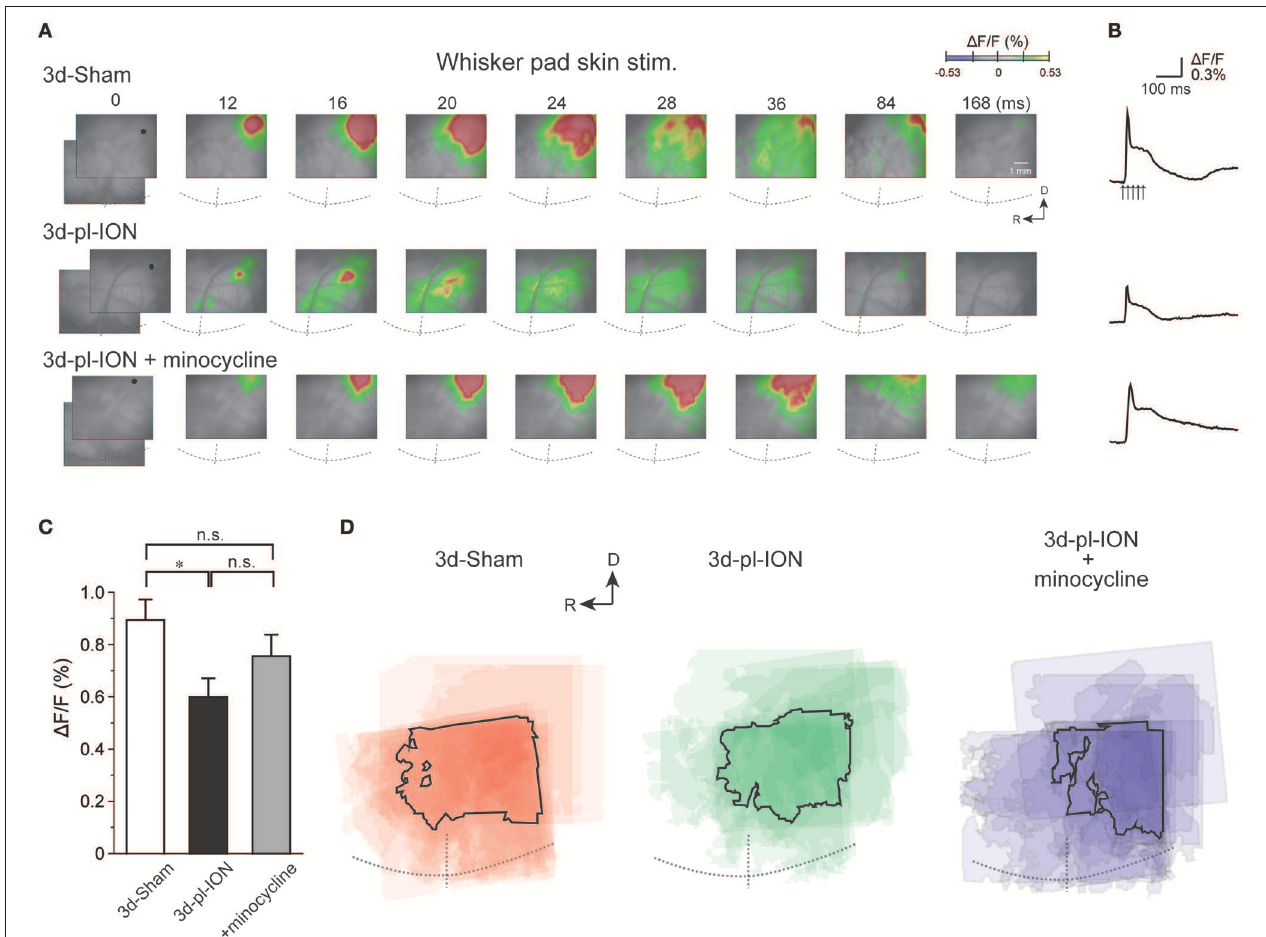
FIGURE 2 | Cortical responses to electrical stimulation of the whisker pad skin. (A) Representative examples of cortical responses in 3 d after sham operation (3d-Sham), 3 d after pl-ION (3d-pl-ION), and 3d-pl-ION that received minocycline administration (3d-pl-ION + minocycline). The time from the onset of the electrical stimulation of the whisker pad skin is shown on the top of each panel. R, rostral; D, dorsal. (B) Temporal profiles of optical signals in the regions of interest (ROIs; black circles) in S1/S2 shown in (A) . (C) The amplitude of S1/S2 excitation in 3d-Sham ( N = 18), 3d-pl-ION ( N = 13), and 3d-pl-ION with minocycline ( N = 15). (D) Superimposed images of the maximum responses evoked by the whisker pad skin stimulation. The number of overlapping responses is represented by gradation of the color density. The line outlines the area responding to stimulation in 50% of animals. * P < 0.016, Student’s t -test with Bonferroni